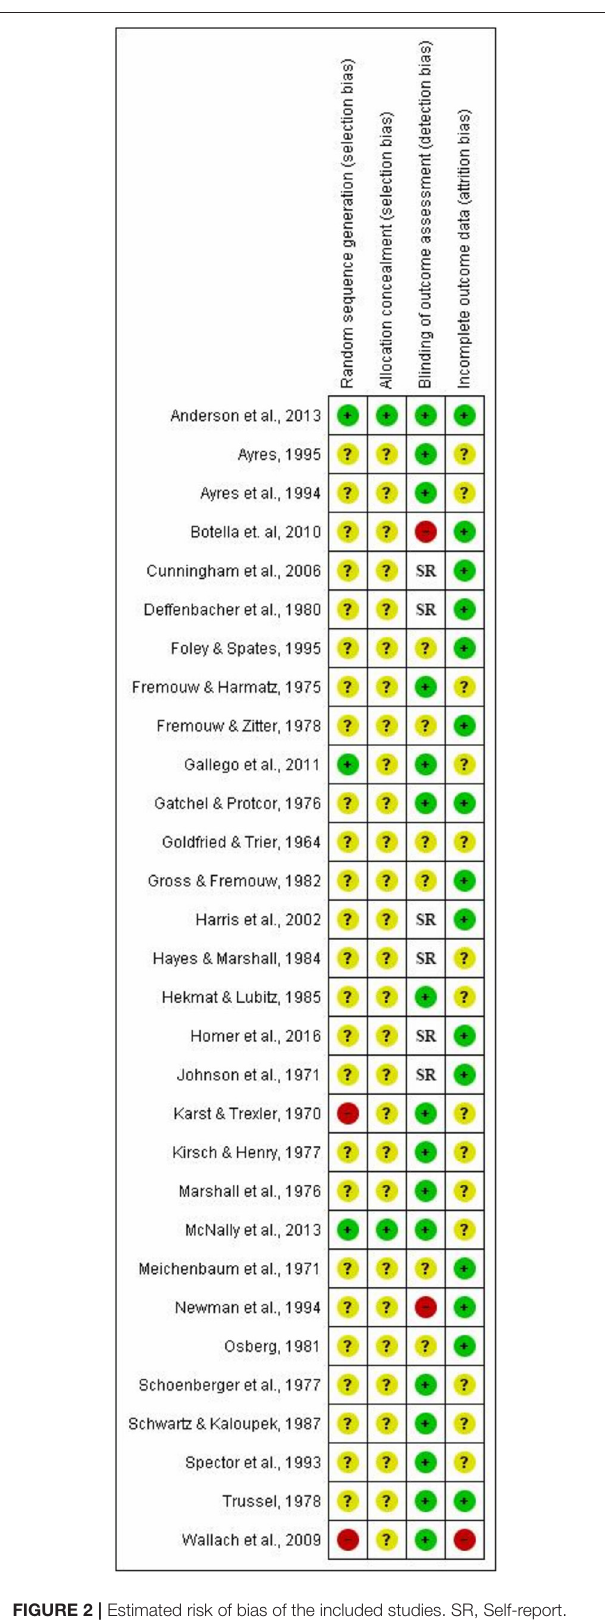
FIGURE 2 | Estimated risk of bias of the included studies. SR,